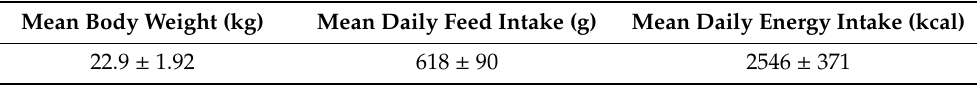
Table 2. Mean body weight and daily feed and energy intake of 20 dogs from days 1 to